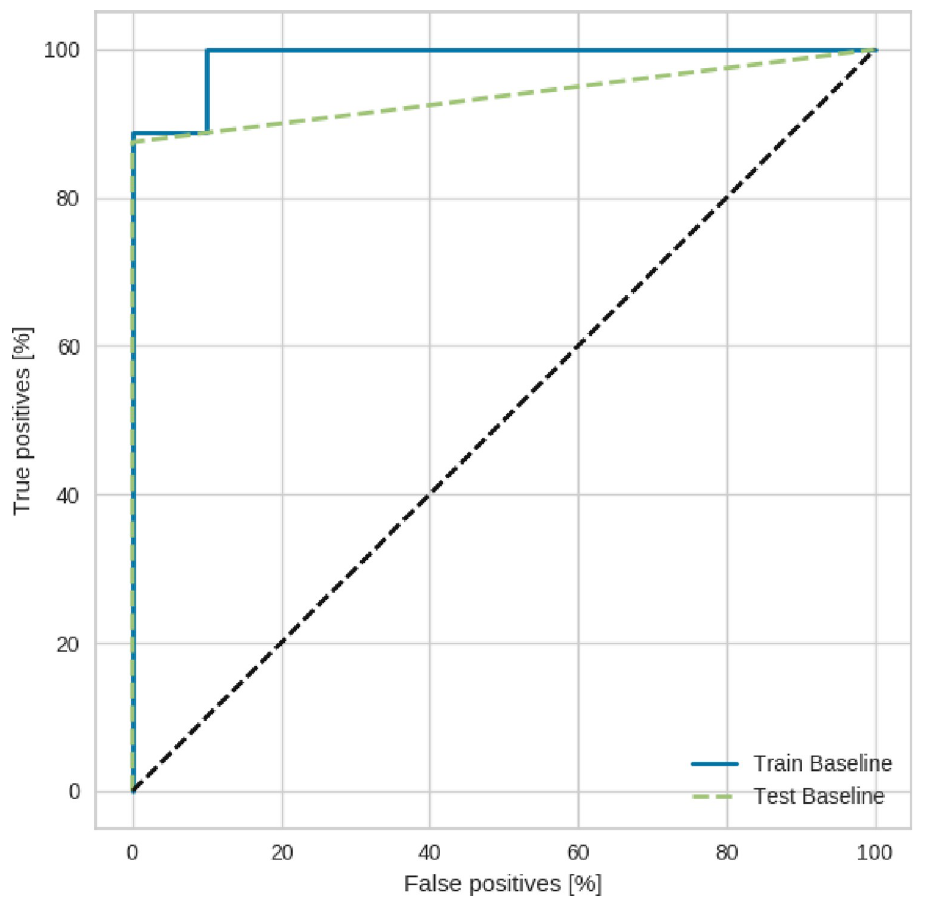
Fig 5. ROC curves for prediction model to rigid body rotation pattern in noncompaction cardiomyopathy patients. The continuous blue line shows the ROC curve obtained from the model’s performance during the training stage. The dashed orange line shows the ROC curve obtained during the test